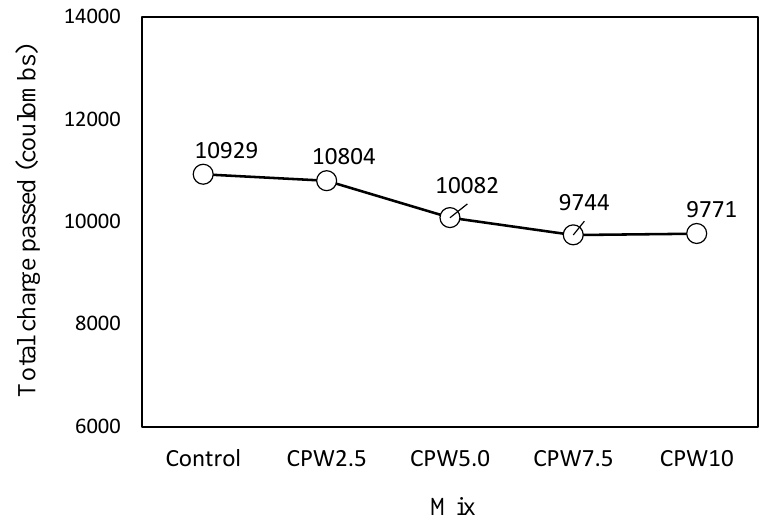
Figure 12. Chloride-ion penetrability of the samples after 28 days.